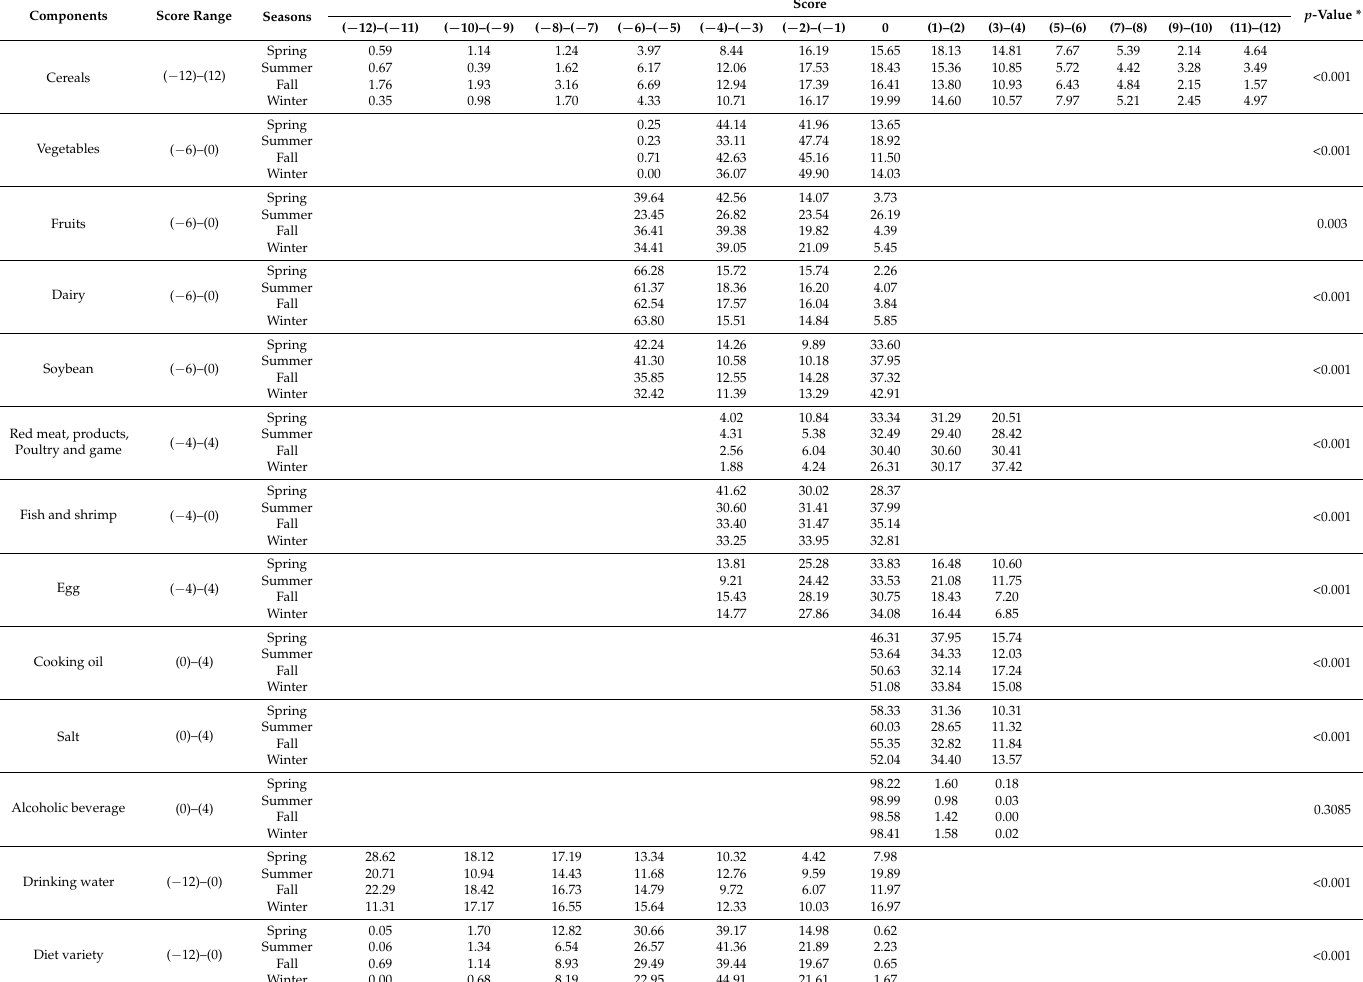
Table 2. Score for the components of food intake, and percentage of Shanghai residents with each score among four seasons (%).